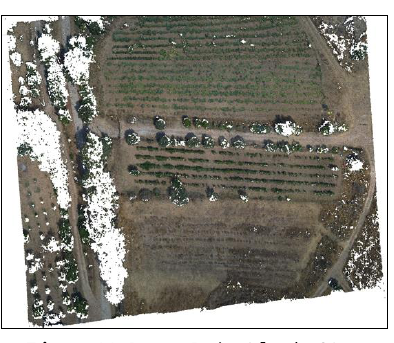
Figure 8. r.m.s. GCPs – 80 m flight